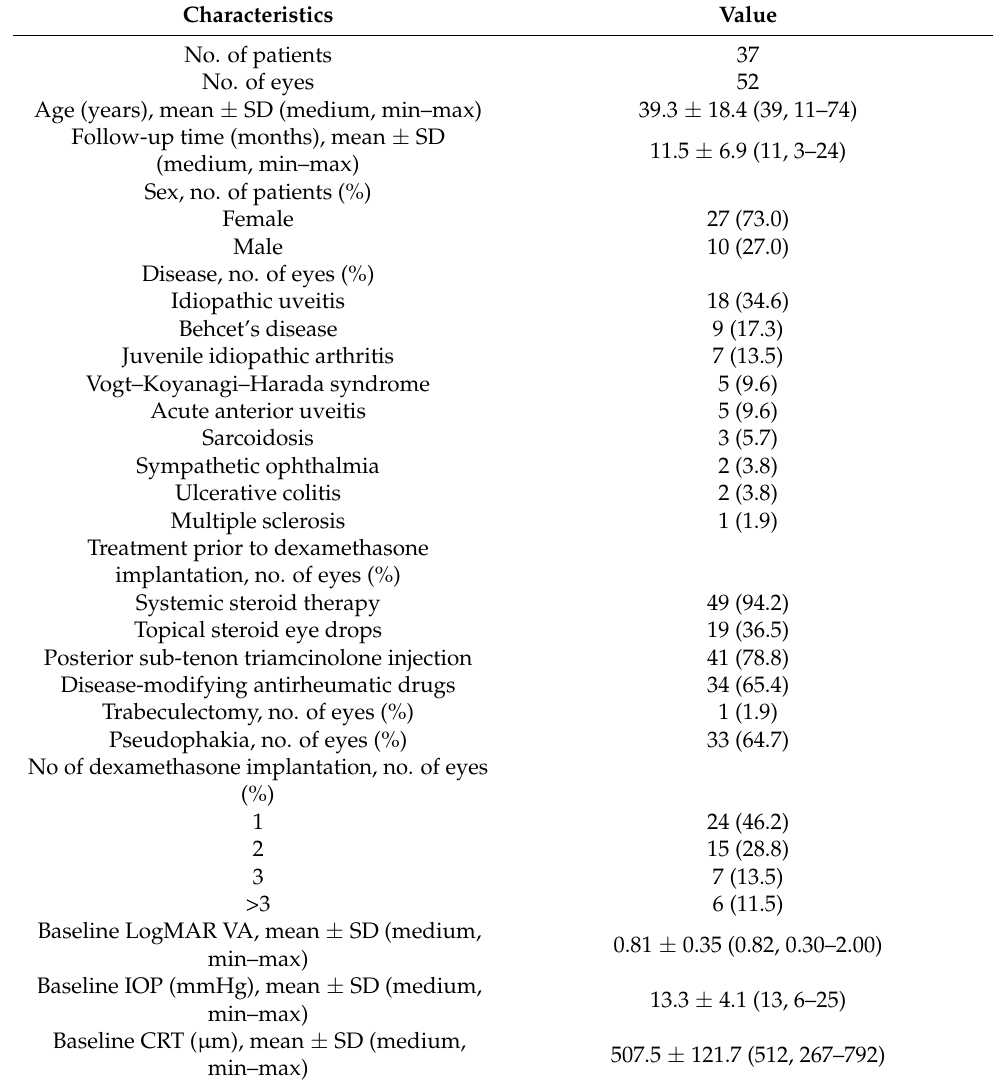
Table 1. Baseline demographics of patients treated with intravitreal dexamethasone